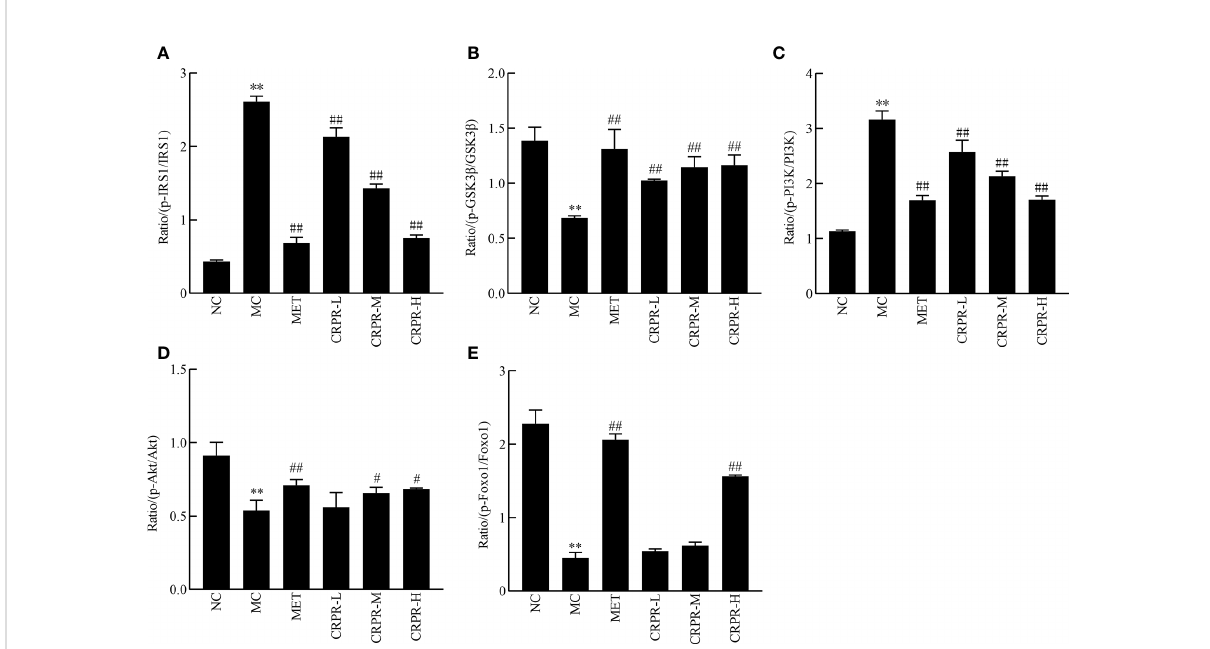
FIGURE 8 The relative expression of p-IRS1/IRS1, p-GSK3 b /GSK3 b , p-PI3K/PI3K, p-Akt/Akt and p-FOXO1/FOXO1. The bar graphs show the effects of CRPR on the (A) p-IRS1/IRS1, (B) p-GSK3 b /GSK3 b , (C) p-PI3K/PI3K, (D) p-Akt/Akt and (E) p-FOXO1/FOXO1 ratios. All values are presented as the mean ± SD. ** P < 0.01 vs. the NC group; # P <0.05 and ## P < 0.01 vs. the MC